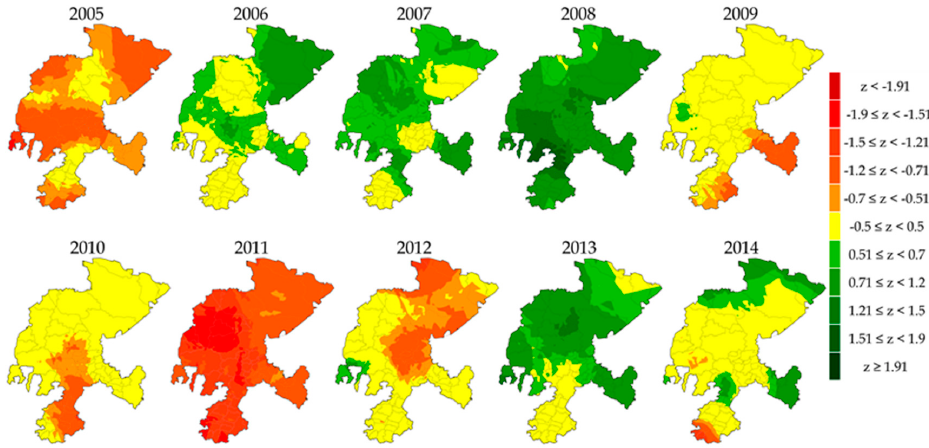
Figure A4. Six ‐ month timescale Reconnaissance Drought Index (April–September).